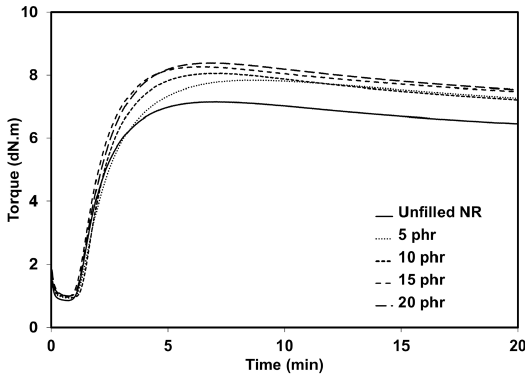
Figure 4. Curing curves of unfilled and sepiolite filled NR